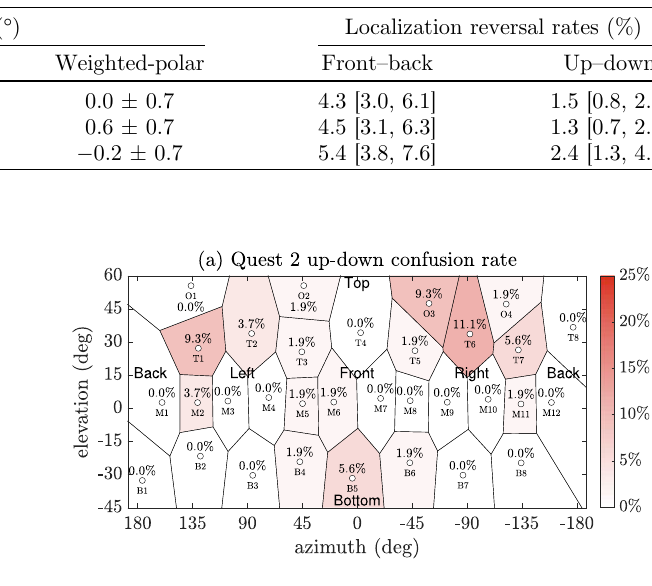
Figure 6. Local great circle angle error across HMD conditions and participants self-reported localization expertise.